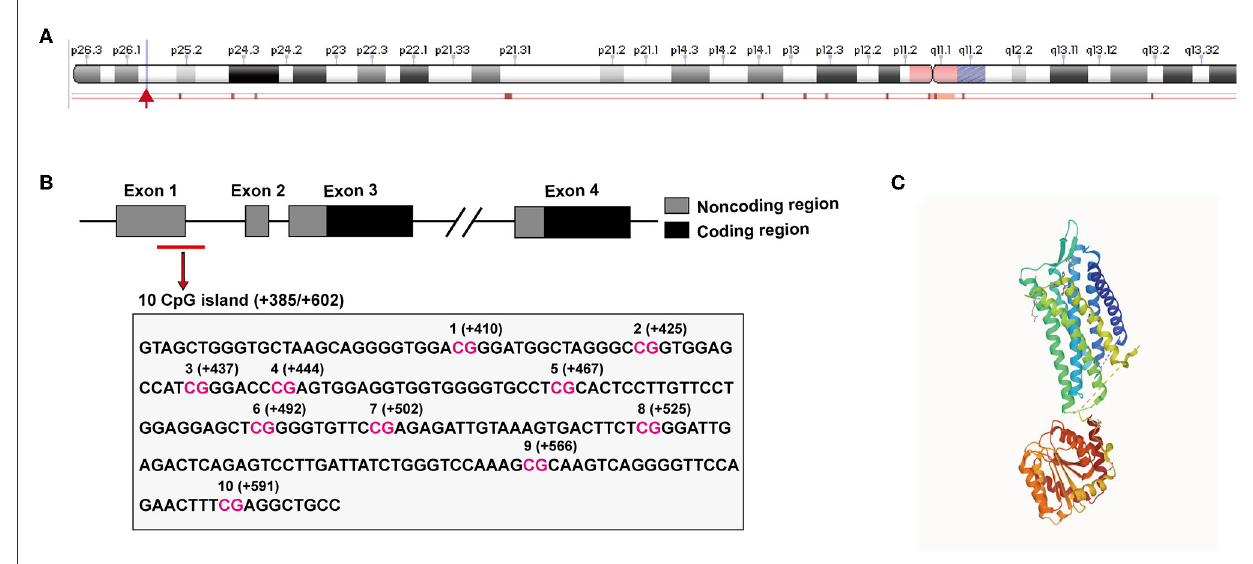
FIGURE1 OXTR gene structure and tissue expression in humans. (A) The location of the OXTR gene on the human chromosome 3 (The information was obtained from the NCBI: OXTR gene 5021) is labeled with a red arrow. (B) Gene schematic of OXTR in humans. Exons are indicated by boxes (coding, black; untranslated, gray). Introns are shown with solid lines. The black box below the OXTR gene denotes CpG islands which function as DNA hypermethylation sites. The figure was generated using information obtained from Cho et al. (2019). (C) X-ray crystal structure of OXTR protein (PDB database: